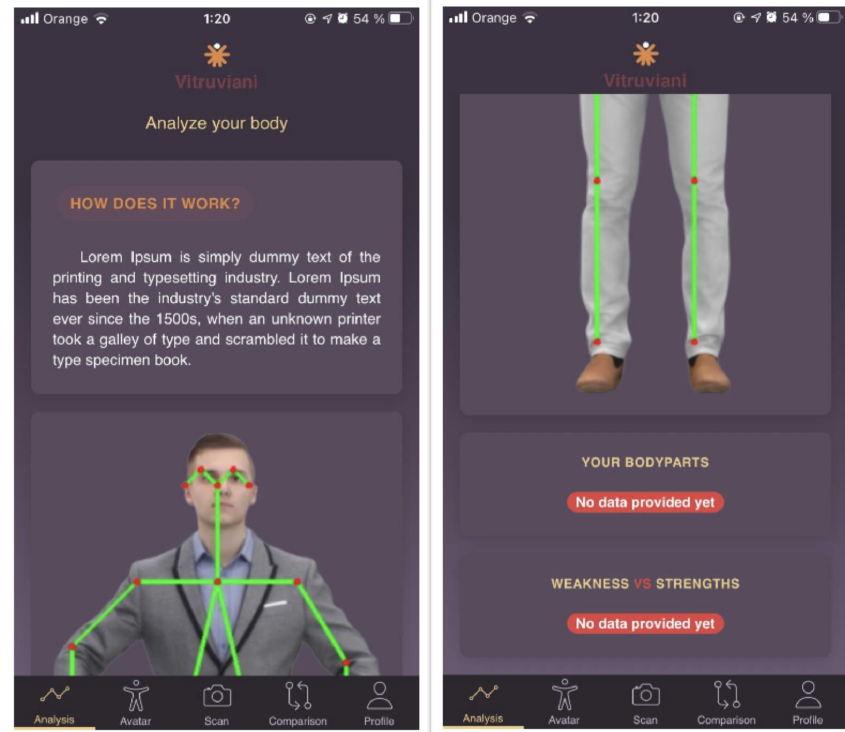
Figure 6. Sample analysis page of the user.